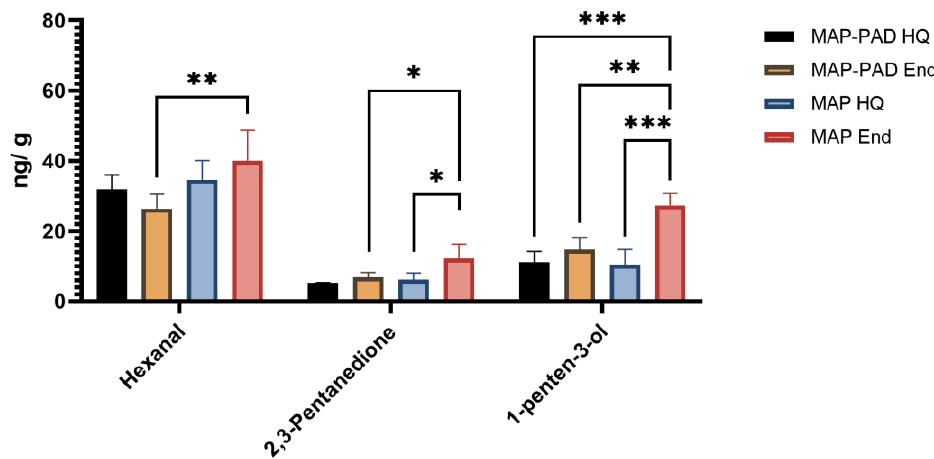
Figure 5. Concentration (ng/g) of target compounds identified via HS-SPME-GC-MS analysis in seabass fillets, packed in active packaging with (MAP-PAD) or without (MAP) a pad, at the high quality (HQ) time point or the end of high-quality (End) shelf-life. (*) stands for p < 0.05; (**) stands for p < 0.01; (***) stands for p < 0.001.